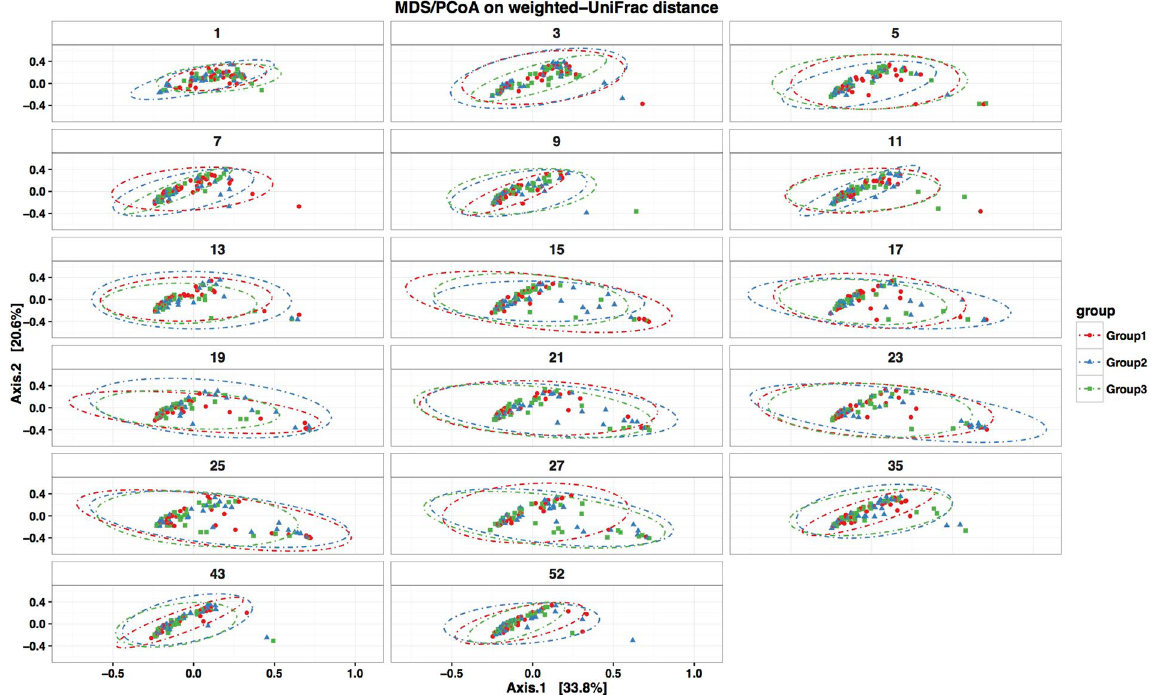
Figure 4. Clustering of nasopharyngeal microbial profiles by group in the first year of life. The phylogenetic dis(similarities) among communities from the three vaccination groups were evaluated by MDS/PCoA on weighted-UniFrac distances. The dotted eclipses show the 95% confidence intervals for the ordinations for each group at each time point. Each circle represents the microbial profile of a nasopharyngeal specimen from an infant and the colour denotes the vaccination group; red for Group 1, green for group 2 and blue for Group 3. The distance between circles indicates the variability between nasopharyngeal microbial profiles i.e. longer distances show greater dissimilarity.